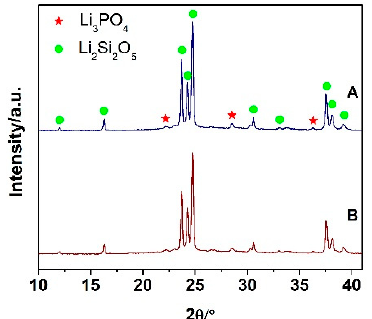
Figure 1. XRD patterns acquired from the materials A and B.